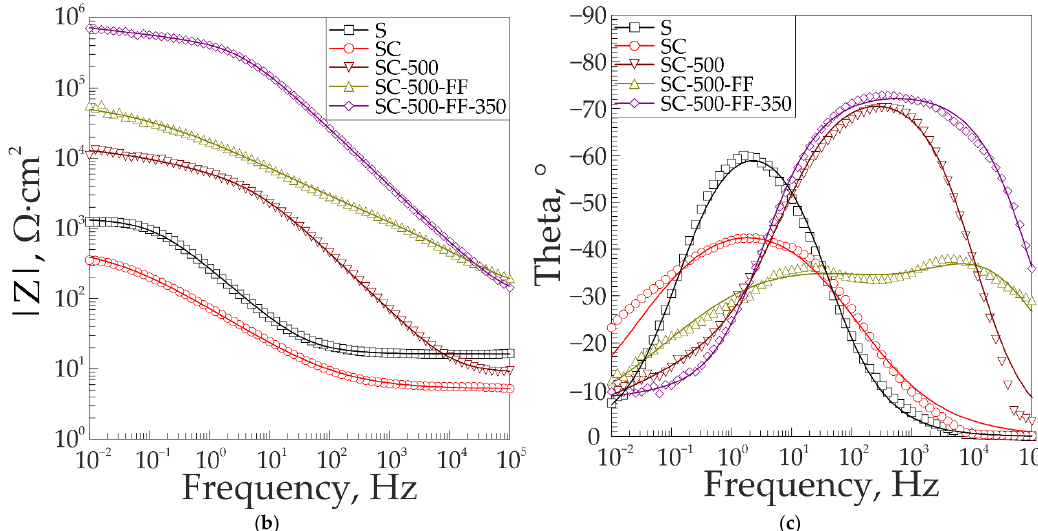
Figure 7. Nyquist ( a ) and Bode plots ( b , c ) for the samples at various stages of processing.